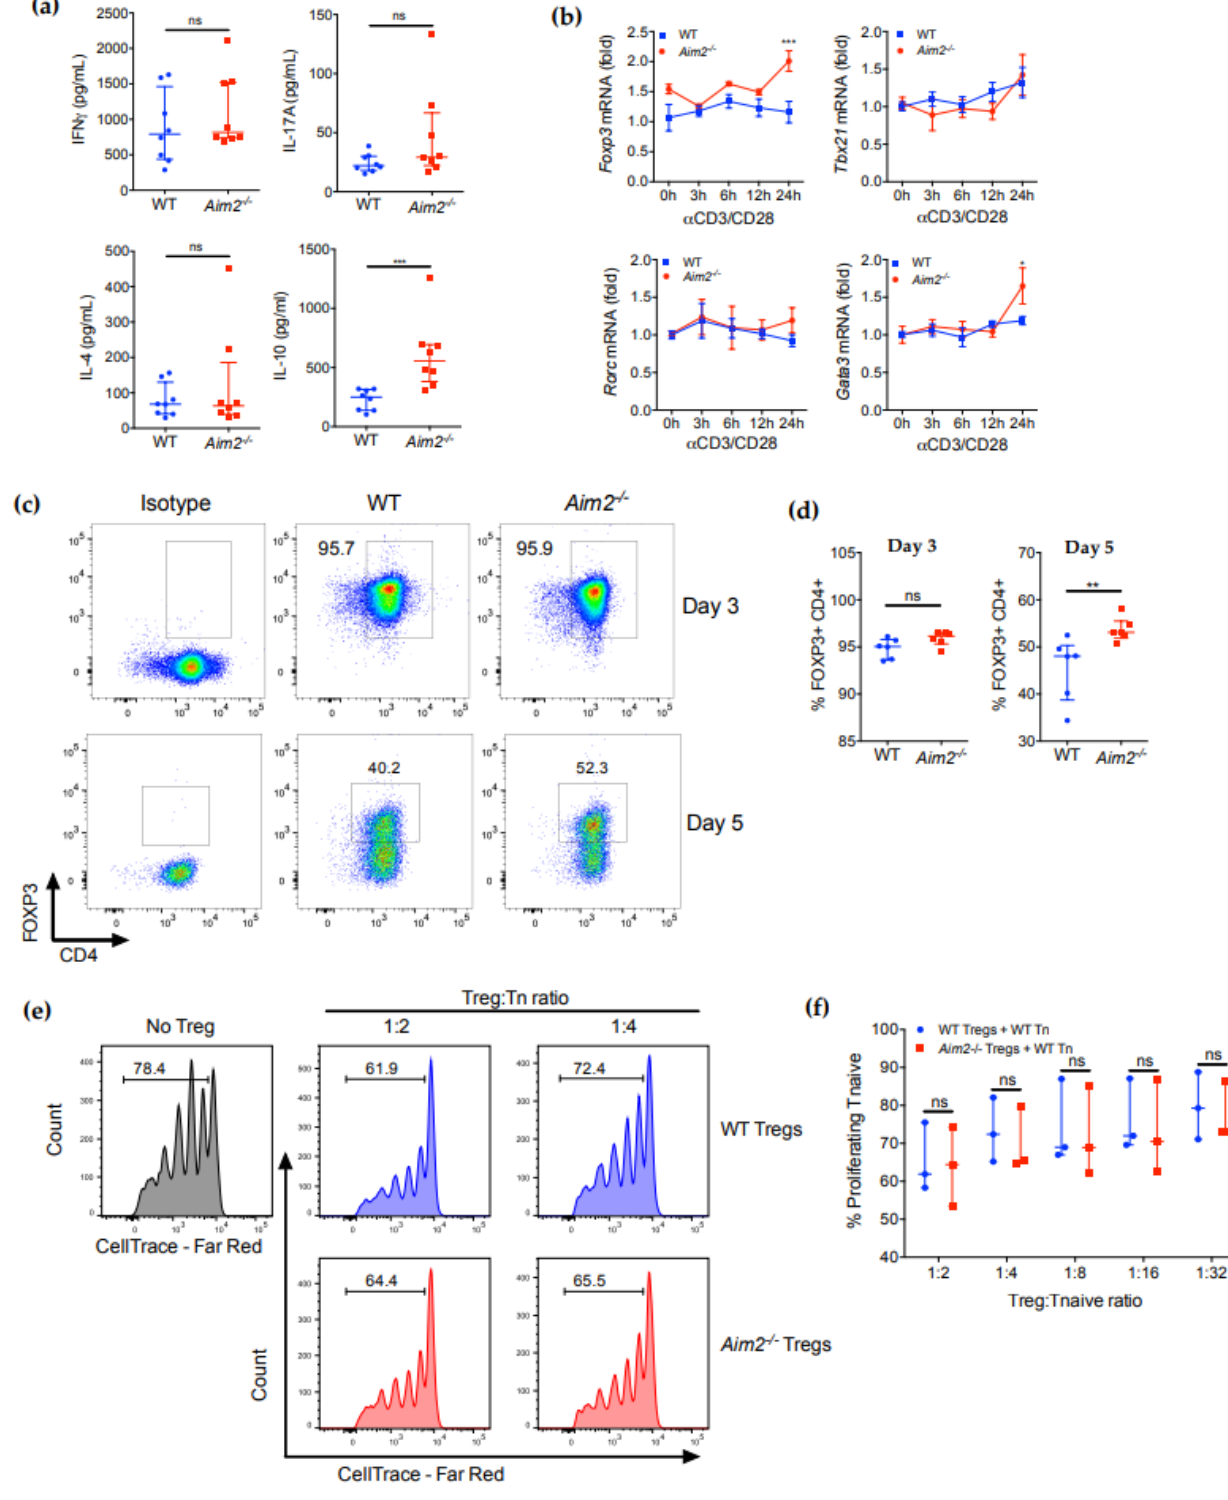
Figure 2. Lack of AIM2 promotes FOXP3 expression in vitro but does not affect the suppressive ability of Treg cells. ( a ) Cytokine levels in culture supernatants of splenic CD4 + T cells from WT or Aim2 − / − mice stimulated with anti-CD3/CD28 antibodies for 24 h. ( b ) RT-qPCR analysis of Foxp3 , Tbx21 , Gata3 and Rorc mRNA expression in splenic CD4 + T cells isolated from WT or Aim2 −/− mice ( n = 4/group) and stimulated with anti-CD3/CD28 ( α CD3/28) antibodies for the indicated timepoints. ( c ) Flow cytometry analysis of FOXP3 expression in naïve CD4 + T cells from WT or Aim2 − / − mice